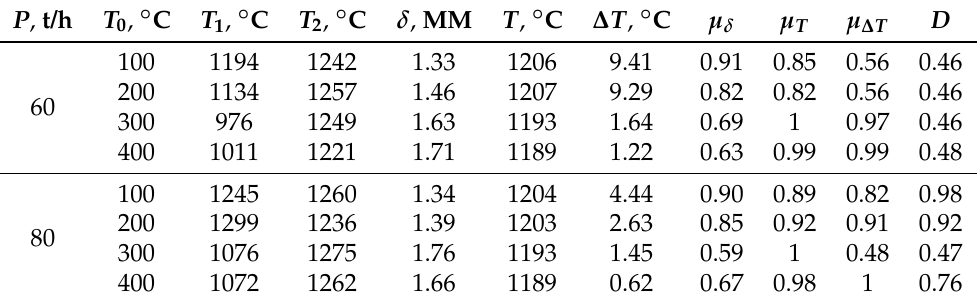
Table 1. Results of solving the optimization problem for the cold ingot